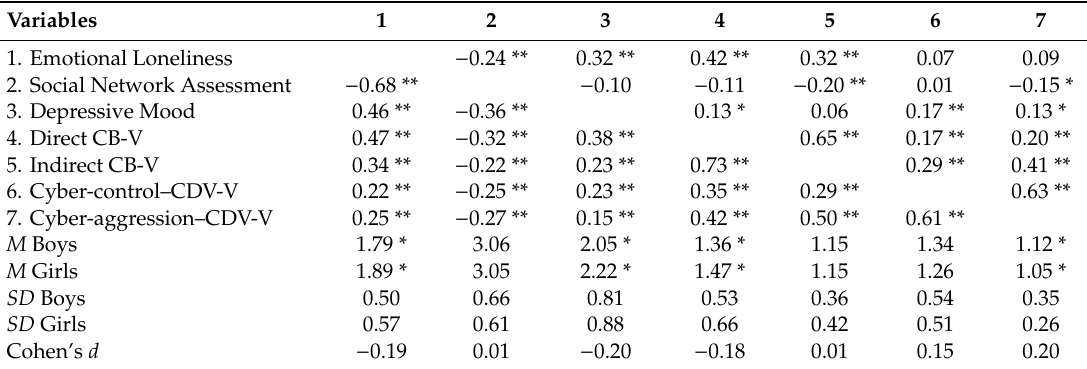
Table 2. Means, standard deviations and correlations among variables (boys above the diagonal).